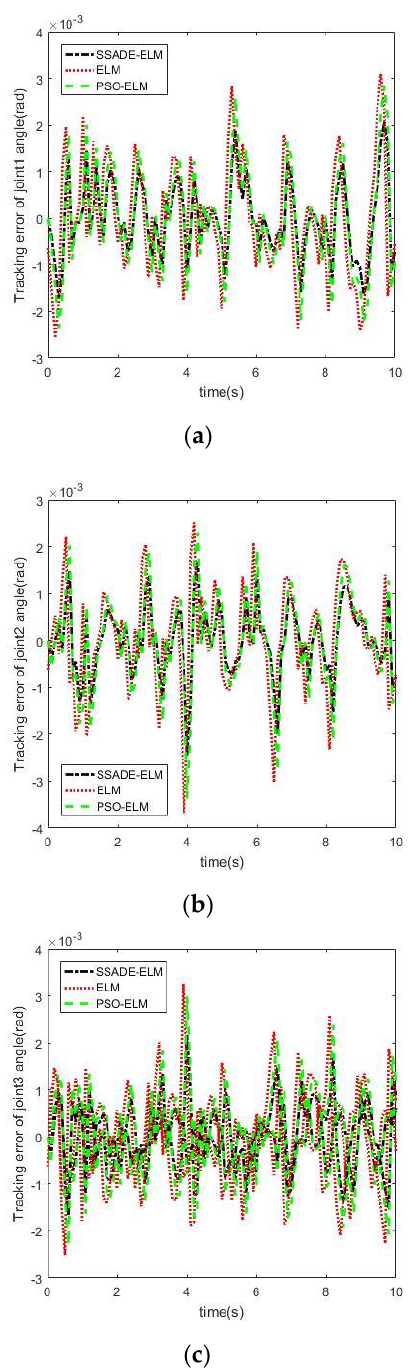
Figure 8. The tracking error of each joint trajectory of control algorithms by simulation. ( a ) The tracking